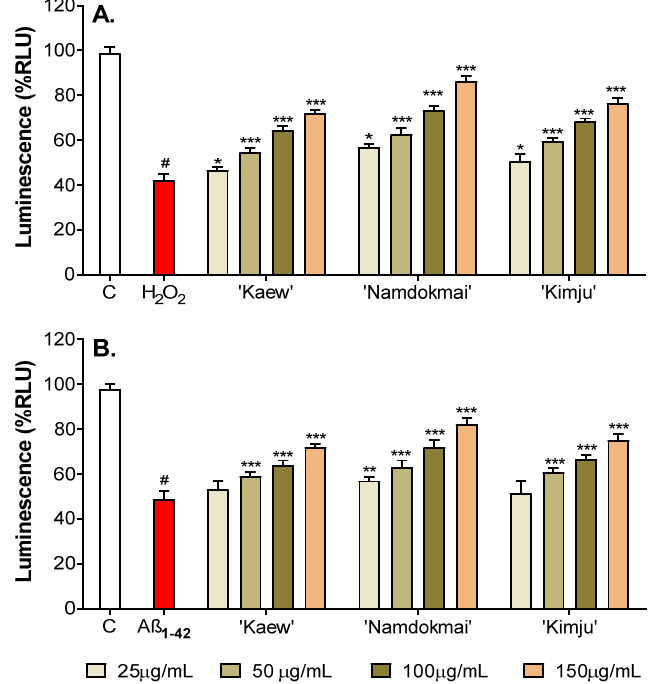
Figure 4. Neuroprotective effect of selected fruit extracts ( M. indica ‘Namdokmai’, M. indica ‘Kaew’ and P. guajava ‘Kimju’) on oxidative stress in PC-12 cells investigated using a glutathione (GSH) assay. Antioxidant GSH level in PC-12 cells after treatment with ( A ) H 2 O 2 and ( B ) A β 1–42 was compared to the untreated control group. The GSH levels of the co-treatment between the selected fruit extracts at different concentrations (25, 50, 100 and 150 µg/mL) and oxidative inducers (H 2 O 2 and A β 1–42 ) were compared to its oxidative inducer treated group. RLU: relative light unit; C: untreated